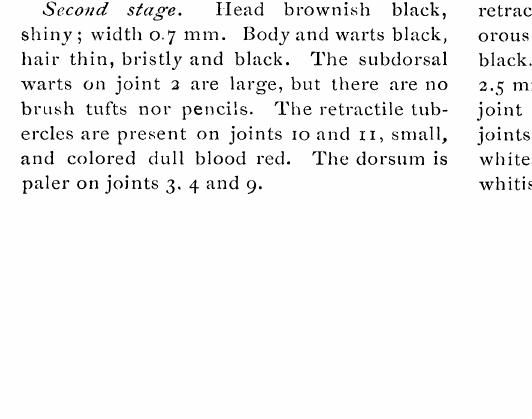
. Spalgis s-signata Holland. Fig. Chrysalis enlarged. Fig. 2. Same. Chrysalis, nat. size. Fig. 3" Same. Larva. Fig. 4" Same. Imago. Third stage. Head black with a brownish tinge, labrum white; width I.t-I. 3 mm. Body black except on the dorsum of joints 3 and 4 where it is yellowish white with a black dorsal line, and also a yellowish sub- dorsal spot on joints 9 and IO (anteriorly). Warts all black; hair long, black with pen- cils of short, plumed, black hairs from the subdorsal warts of joint (none on joint 2). There are small, dorsal, black, brush-like tufts on joints 5 and 6 and a few short tufted white hairs on joints 7 and 8. The warts of row 2 on joint 9 are a little tinged with red. Retractile tubercles red. Length of larva about 9 rain. fi’orth stage. Head brownish black, la- brun and antennae sordid white; width .7- .8 mn. Body greenish black below, gray on the sides, a black subdorsal and yellow subventral line. Dorsum largely sordid yel- low; cervical shield, a dorsal line on joints 3 and 4, a shade surrounding the tufts on joints 5-8, and a broad band from joint 9 posteriorly to joint I2, all black; joint 13 dark gray. The warts of rows 1-.5 and the retractile tubercles are all blood red, concol- orous, except those on joint 2 which are black. The plumed pencils on joint 2 are 2.5 mm. long, and there is now also one on joint I2 dorsally. The brush-like tufts on joints 5 and 6 are brown, those on 7 and 8 white. The other hair is long and black but whitish